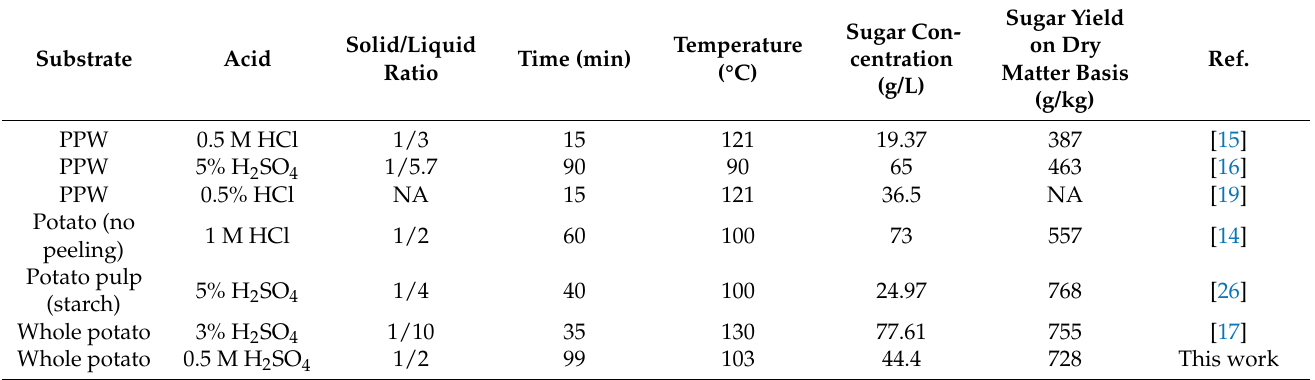
Table 7. Comparison of potato waste acid hydrolysis results. PPW—Potato Peel Waste, NA—Not Available.